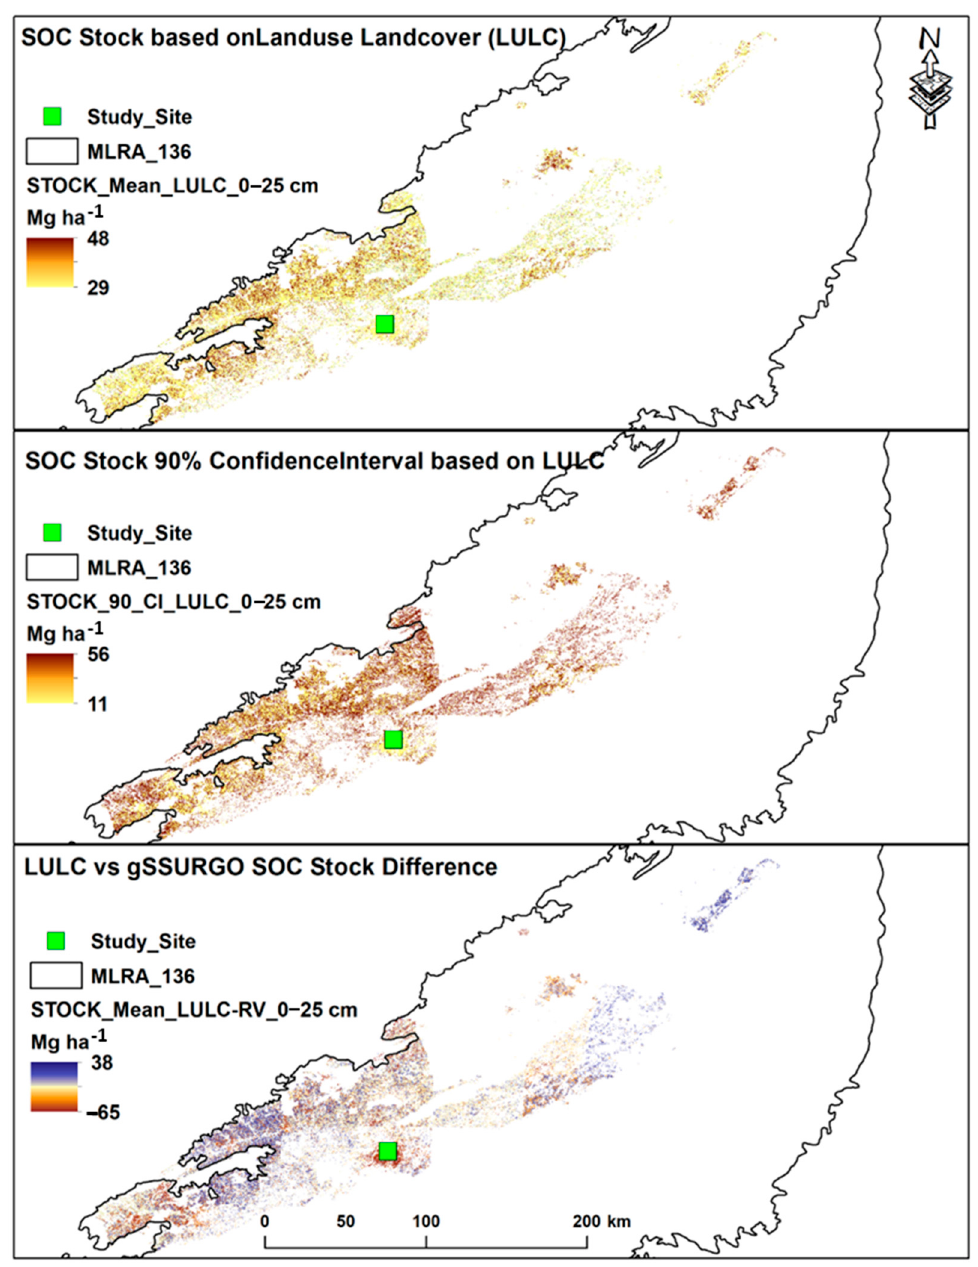
Figure 8. Mean SOC stock distribution at a regional level for the Fairview series area (including the study area), based on measured values from prairie grass, lawn grass and forest sites, assigning the 2019 USGS-LULC categories ( upper panel), 90% confidence interval for the mean SOC stock ( middle panel), and the difference between the mean SOC stock calculated based on 2019 USGS-LULC and the gSSURGO ‐ RV.